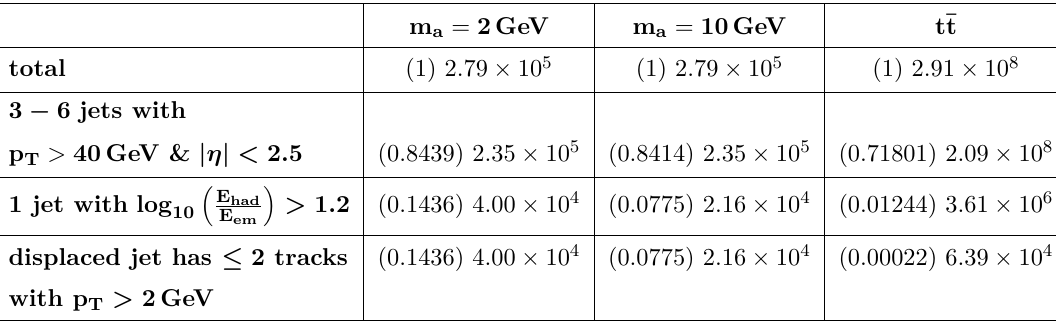
Table 1 . Cut flow of the expected number of events for signal and background events for LHC run √ 3 with s = 13 TeV and L = 350 fb − 1 . The values in brackets are the efficiencies after each cut. For the signal cτ ALP = 0 . 1 m and Br( t → aq ) = 0 . 001 was